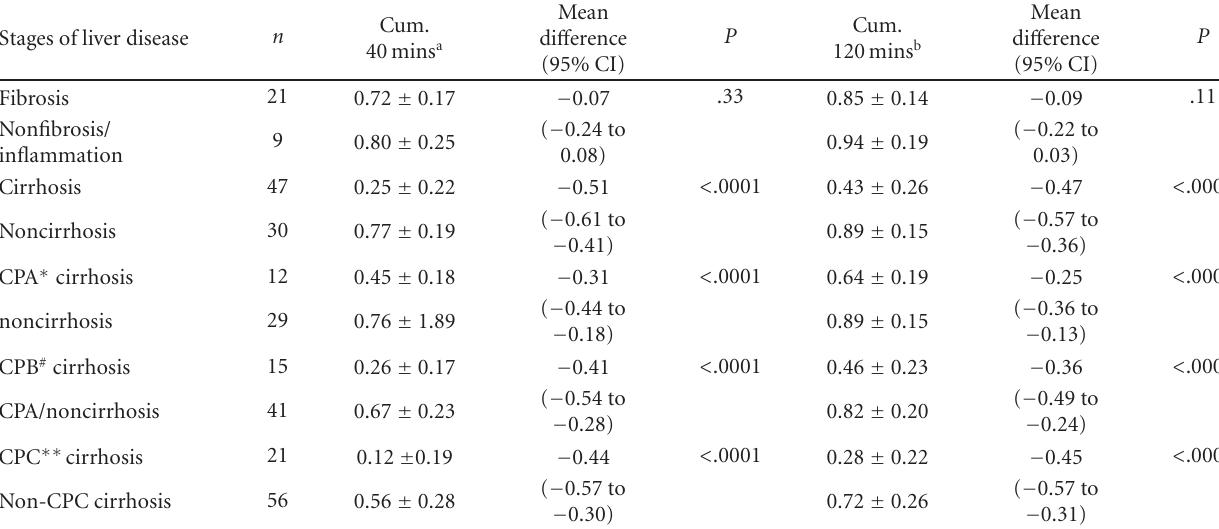
Table 2: Mean values of the cumulative percent oxidation of the 13 C-MBT at 40 and 120 mins in various stages of chronic liver disease. Stages of liver disease